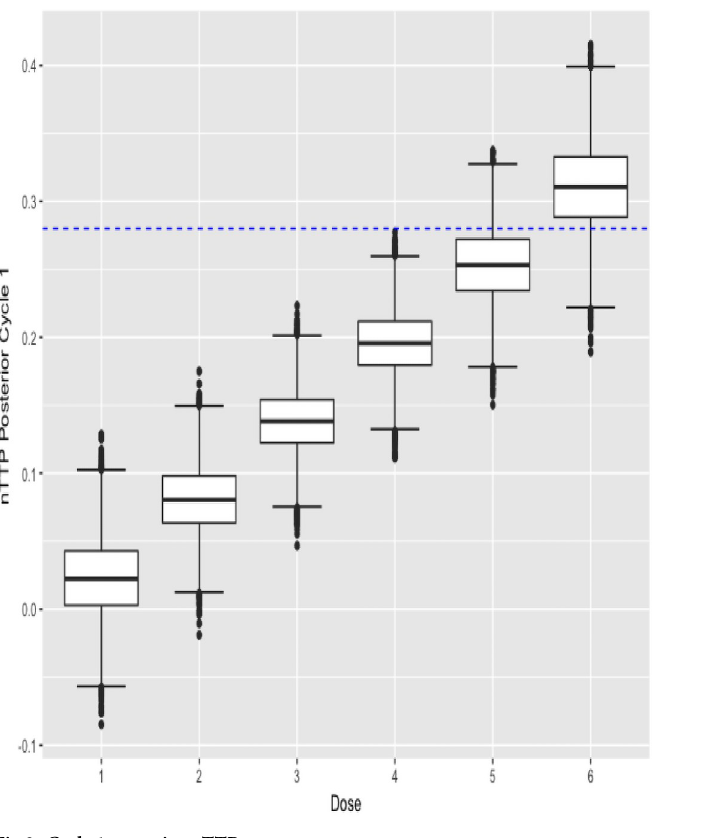
Fig 3. Cycle 1 posterior